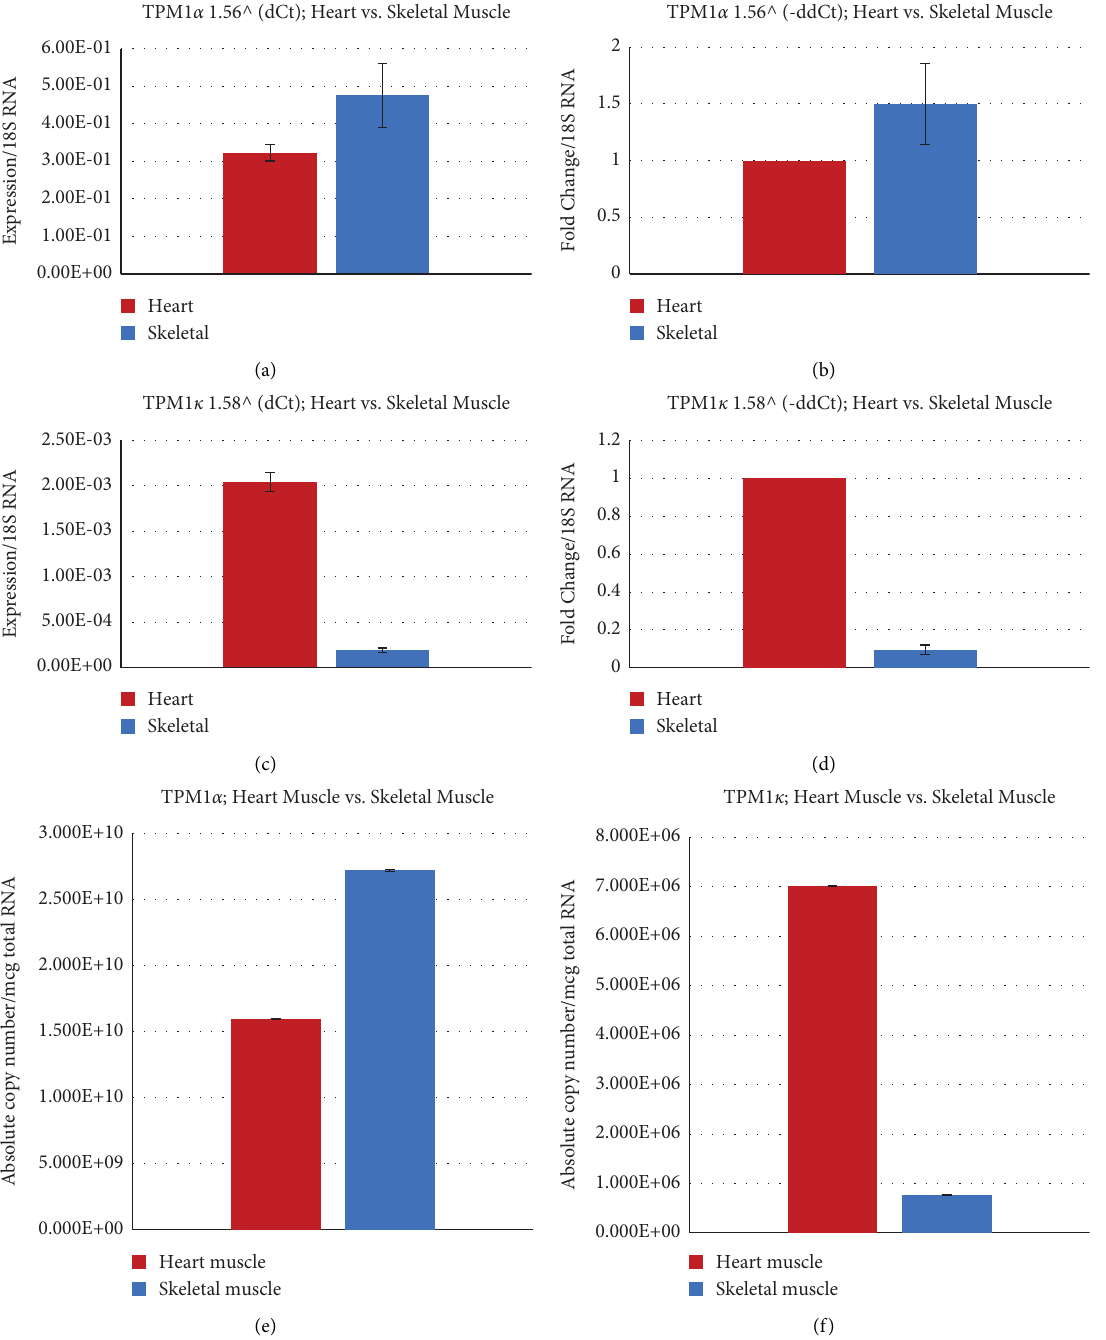
Figure 5: Relative and absolute expression of TPM1 α and TPM1 κ in the Cyn heart and skeletal muscle. (a) Relative expression of TPM1 α using the dCt method. (b) Fold change of TPM1 α using the ddCt method. (c) Relative expression of TPM1 κ using the dCt method. (d) Fold change of TPM1 κ using the ddCt method. (e) Estimation of the absolute copy number of TPM1 α . (f) Estimation of the absolute copy number of TPM1 κ